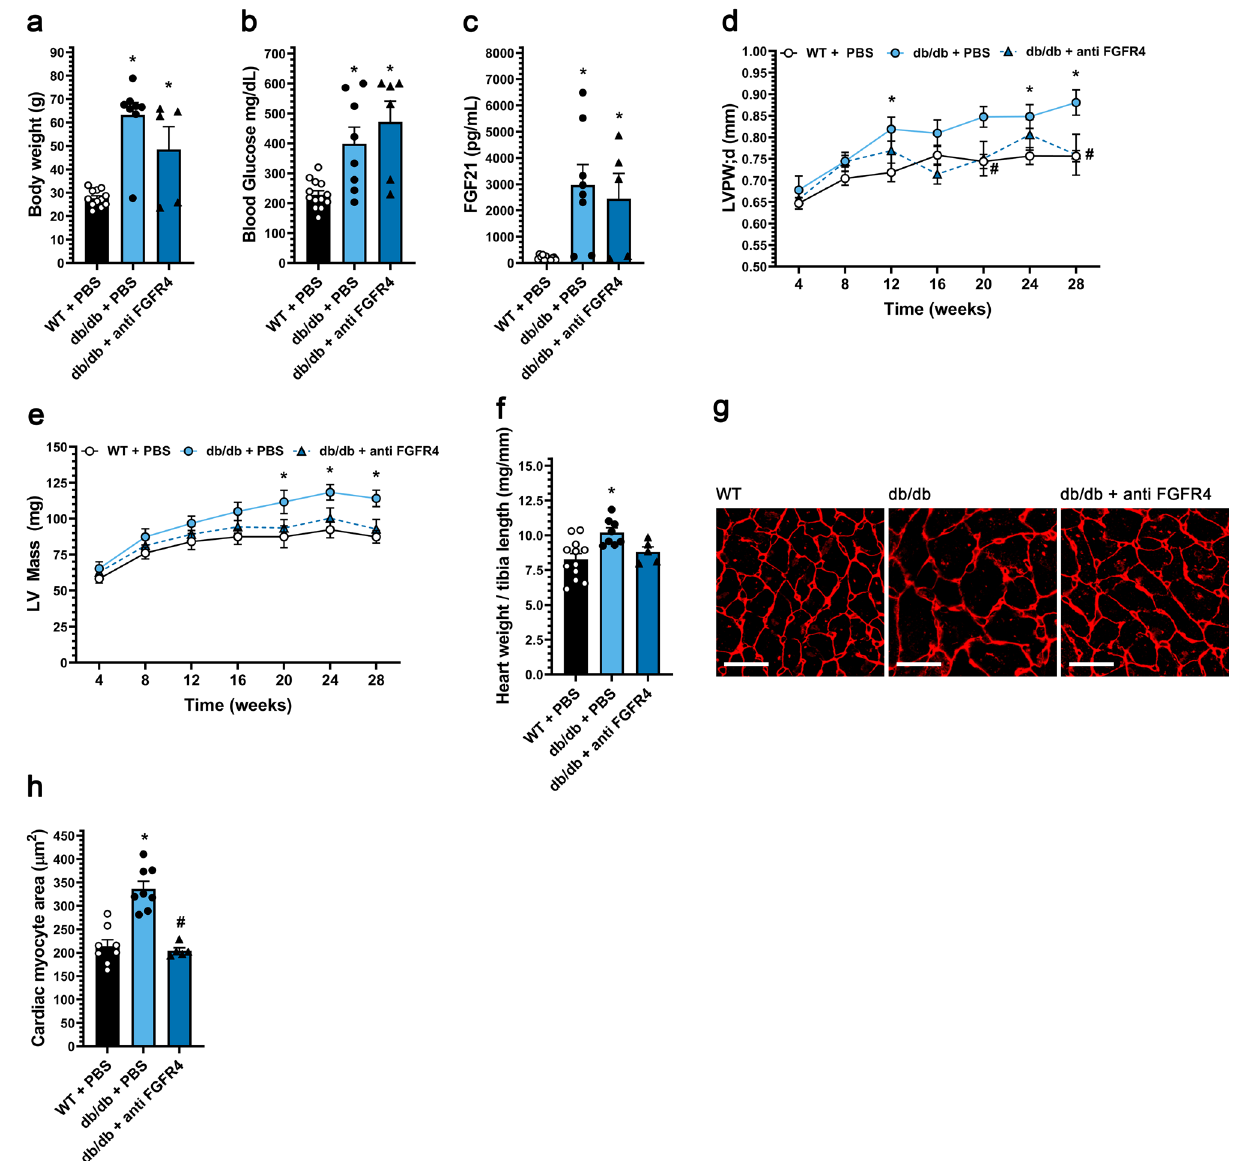
Figure 5. FGFR4 blockade protects diabetic mice from pathologic cardiac remodeling. db/db mice and wild- type (WT) littermates were treated for 24 weeks with either FGFR4 blocking antibody (25 mg/kg) or vehicle (PBS) on a bi-weekly basis, starting at 4 weeks of age. ( a ) Body weight, ( b ) blood glucose levels, and ( c ) serum FGF21 levels. ( d ) left ventricular (LV) posterior wall thickness in diastole, and ( e ) LV mass from 4 weeks until 28 weeks of age, as determined by serial echocardiography. ( f ) Gravimetric heart weight/tibia length ratio, ( g ) wheat germ agglutinin-stained LV tissue section (scale bar = 25 µm), and ( h ) cardiac myocyte cross-section area. Comparison between groups was performed in form of a one-way ANOVA ( a – c , f , h ) or a 2-way ANOVA ( d , e ) followed by a post-hoc Tukey test. All values are expressed as mean ± SEM. ( a , c , f ) N = 5–12; ( b ) N = 6–13; ( h ) N = 5–9, *p ≤ 0.05 vs. WT, # p ≤ 0.05 vs. db/db. ( d , e ) N = 6–13, *p ≤ 0.05 vs. WT of same age, # p ≤ 0.05 vs. db/db of same age. For the complete set of echocardiography parameters see Supplementary Table